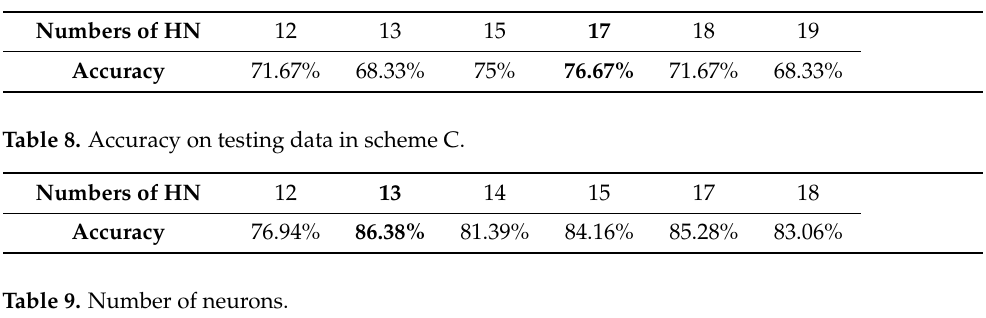
Table 7. Accuracy on testing data in scheme B.